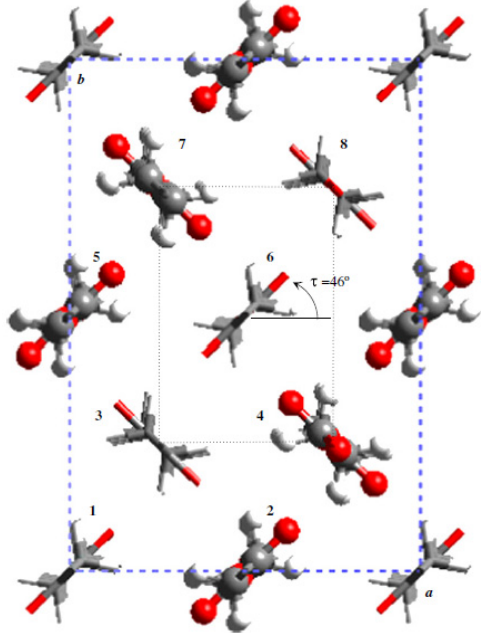
Figure 5. View parallel to the c -axis direction showing the packing of polyester 6,4 assuming a large unit cell with a and b parameters of 1.612 and 1.464 nm, respectively. In projection this packing can be defined by a conventional rectangular cell containing only two chain segments (dotted lines). Reproduced from Gestí et al. [94], copyright (2007), by permission of Elsevier Science